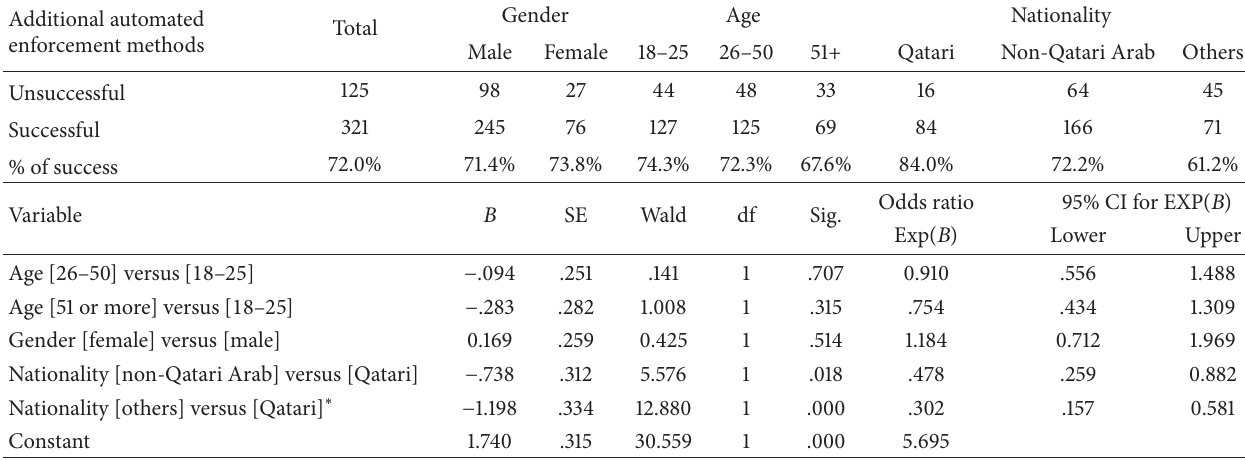
Table 9: Reported success and logistic model results for additional automated enforcement methods strategy.